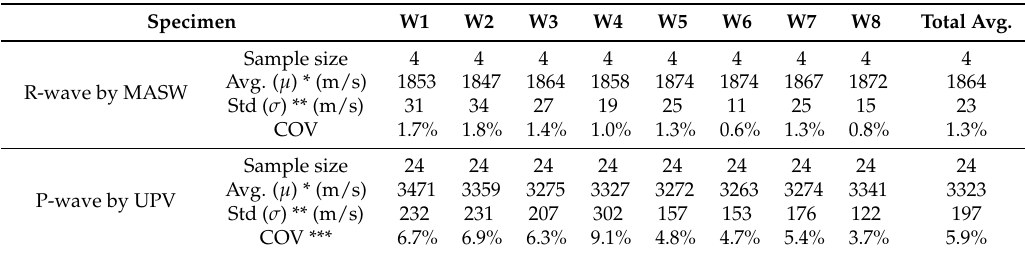
Table 2. Results of the statistical analysis for R-wave velocities.